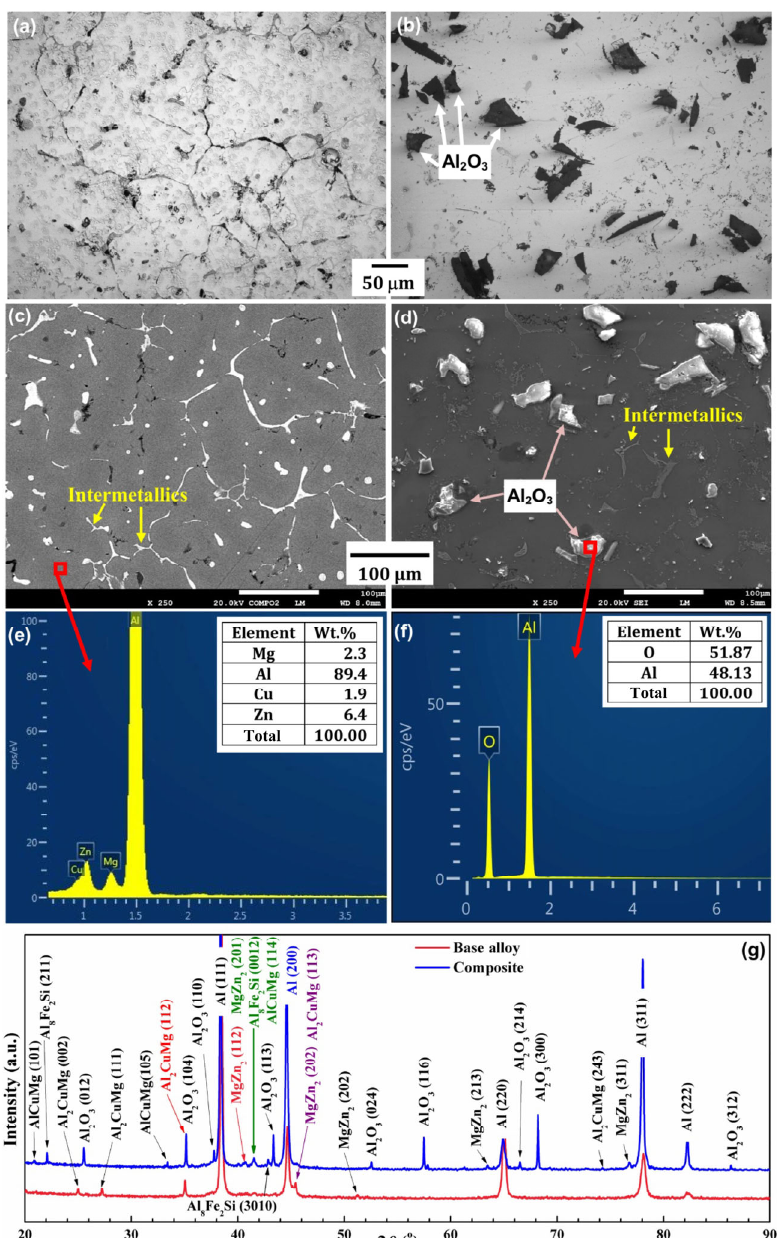
Fig. 1 Typical optical (a–b) and FE SEM micrographs (c–d) of as-cast alloy (a, c) and composite (b, d), (e) and (f) show EDX profiles along with results of semi-quantitative elemental analyses corresponding to the marked areas in (c) and (d), respectively, and (g) presents XRD line profiles of base alloy and